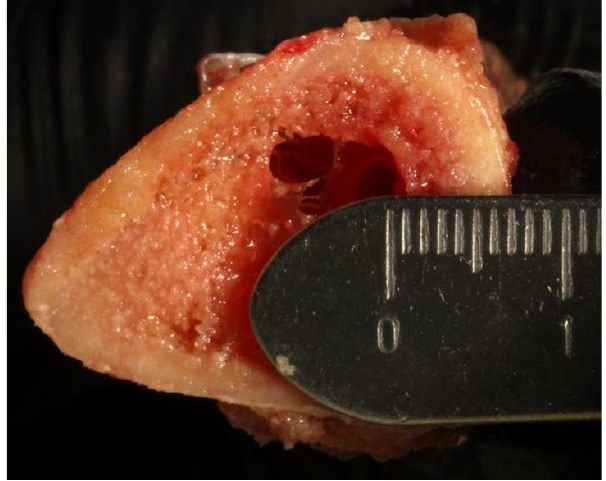
Figure 3. Six (6) mm thickness of the tibiae (3 mm cortical bone and 3 mm cancellous bone).